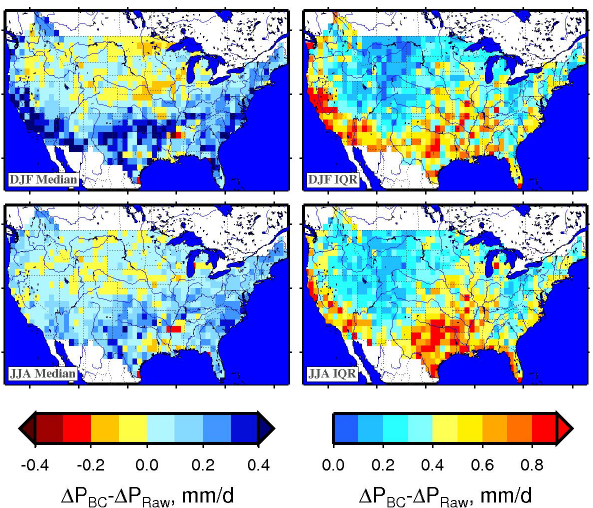
Fig. 6. Ensemble median difference between the BC and raw dif- ferences in precipitation between 1994–2005 and 1979–1993 for DJF (top row) and JJA (bottom row). Right column is the interquar- tile range (IQR), defined as the 75th percentile minus the 25th per- centile.